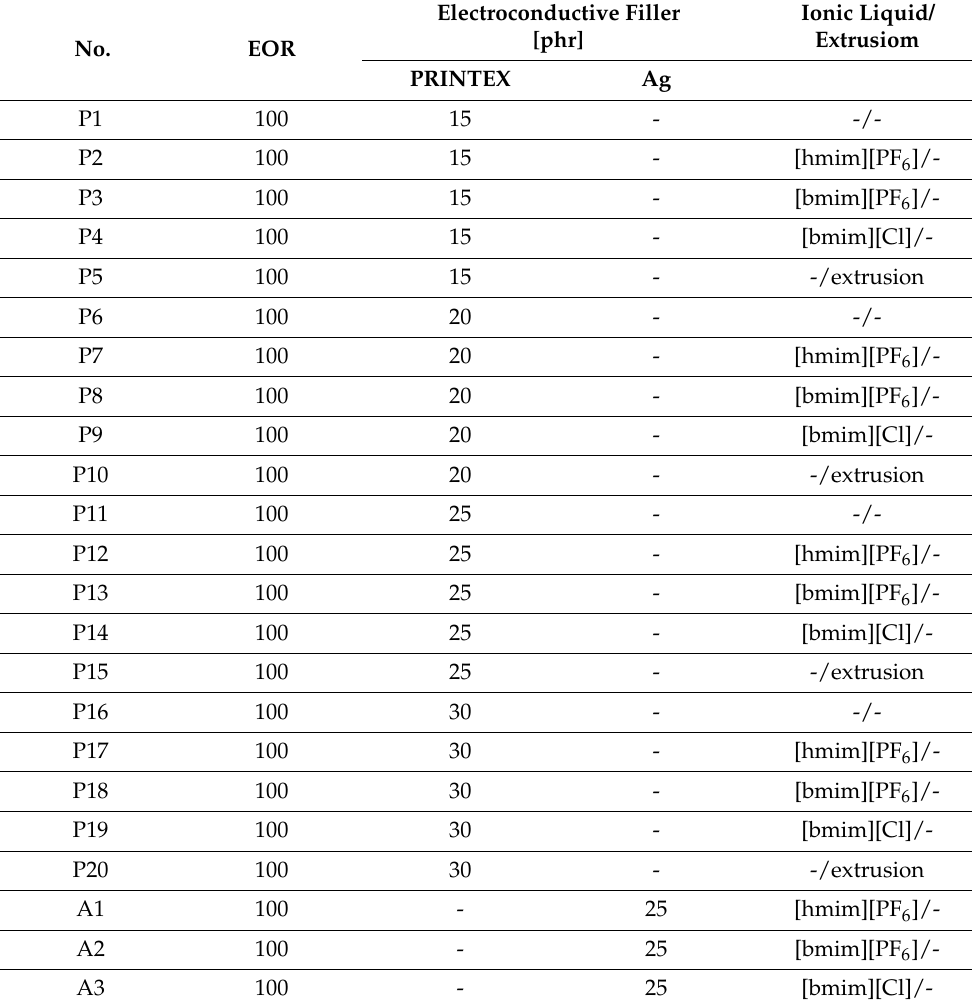
Table 2. The compositions of the polymer blends of ethylene-octene copolymer (EOR) with electro- conductive carbon black (PRINTEX) and silver flakes